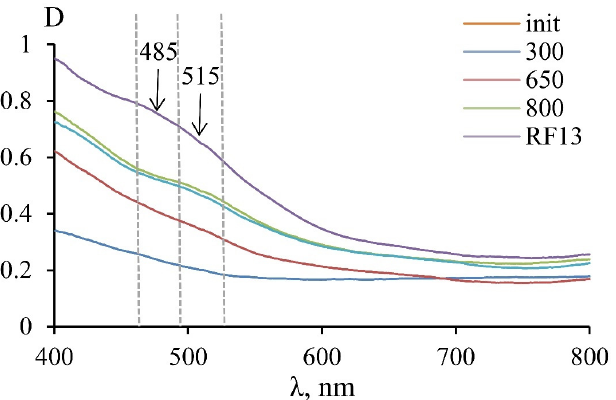
Figure 3. Optical absorption spectrum of MF samples roasted at different temperatures and the RF13 sample roasted at 700 °C. A monotonic decrease in optical density was observed in the initial sample and the MF sample roasted at 300 °C. A violation of this monotonicity in the 460–525 nm region was observed for the MF samples roasted at 650 and 800 °C and for the RF13 sample. Using spectra mathematical processing, it was found that bands with a wavelength of 515 and 485 nm appeared in this region. The appearance of the 515 nm line in the MF5 sample spectrum, roasted at 650 °C, indicated the spin-forbidden d-d transitions in Fe 3+ in the octahedral position in the new phase’s structure, which was also detected according to the results of Mössbauer spectroscopy. An additional band at 485 nm was displayed in the spectrum of the sample roasted at 800 °C, which indicates the appearance of a new octa- hedral position with new linear parameters. According to XRD, the appearance of these lines can be associated with the formation of the serpentine mineral thermal destruction products—amorphous compounds (at 650 °C) and crystalline compounds (at 800 °C). 3.1.4. Activity of MF and RF Series Samples The phase composition change affected the acid-neutralizing ability of serpentine minerals (Figure 4). For the MF series samples, the activity increased at 500–650 °C and reached a maximum at 650–700 °C. Then, a slight decrease in activity occurred at 750 °C, and a sharp decrease occurred at 800°C. Thus, the optimal temperature for obtaining a thermally activated product using a muffle furnace is in the range of 650–750 °C, which corresponds to data obtained earlier [9]. The sharp increase in the sample’s activity ob- tained at a temperature of 600 °C should be noted compared to 550 °C, reflecting the be- ginning of the serpentine destruction already at 600 °C.